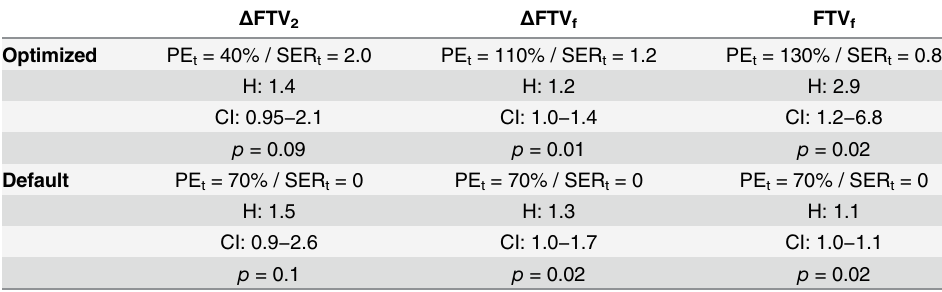
Table 5. Cox proportional hazards ratios at PE t /SER t with optimized association with RFS and at the default setting for patients with TN breast cancer. Δ FTV Δ FTV 2